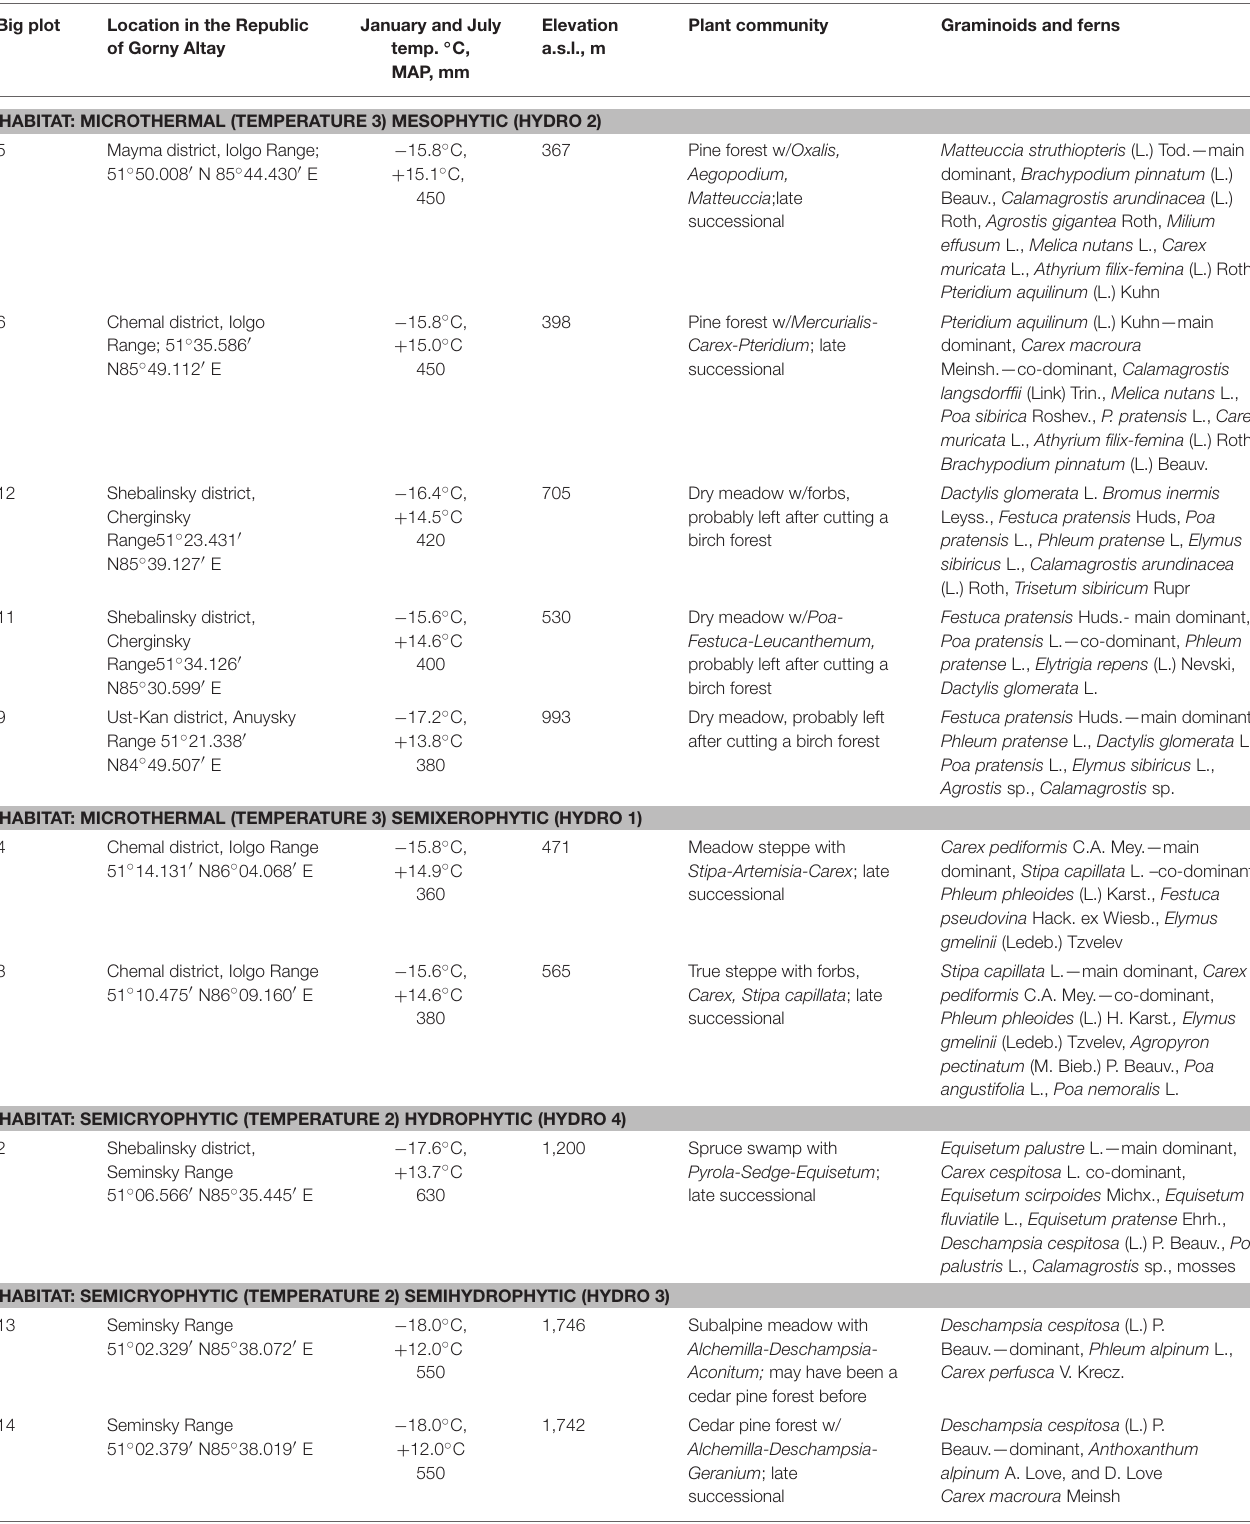
TABLE 1 | Plant communities analyzed in this study. Big